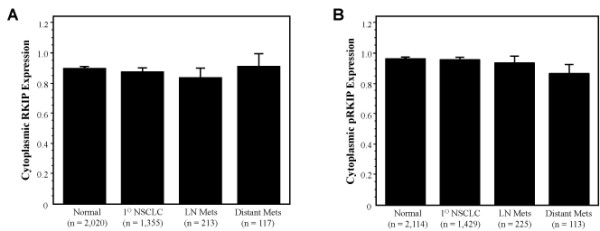
RKIP and pRKIP expression levels as a function of tumor progression. Columns, means, bars, SE. (A) Expression levels are represented by the integrated intensity of RKIP expression in the cytoplasm of relevant cells as described in Materials and Methods. Note, there is no statistically significant difference between any of the expression levels shown. (B) Expression levels are represented by the integrated intensity of pRKIP expression in the cytoplasm of relevant cells as described in Materials and Methods. Note, there was a statistically significant group difference of pRKIP expression (P < 0.0001) with a slight decrease in expression in metastatic cells compared to morphologically normal bronchial epithelium and primary NSCLC lesion.